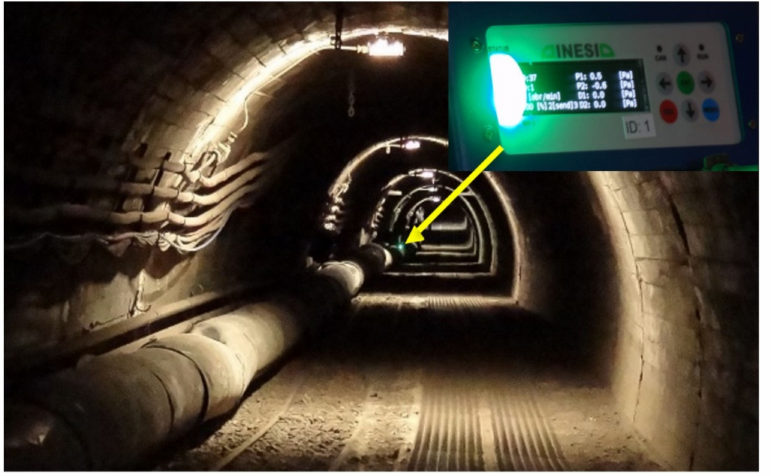
Figure 16. Response of the measuring module for the connector sealing (green, flashing